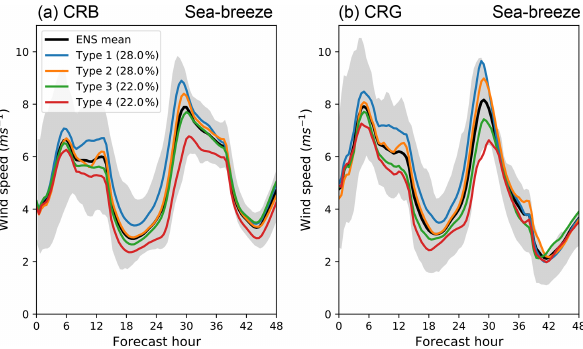
Figure 4. Time series of turbine-height wind speed during the sea- breeze case averaged (a) over the basin (CRB) and (b) across the gorge (CRG). The solid black line indicates the ensemble mean, while the colored lines indicate the mean of each SOM type. The envelope shows the 2.5th and 97.5th percentiles of ensemble mem- bers. Numbers in parentheses indicate the percentage of each